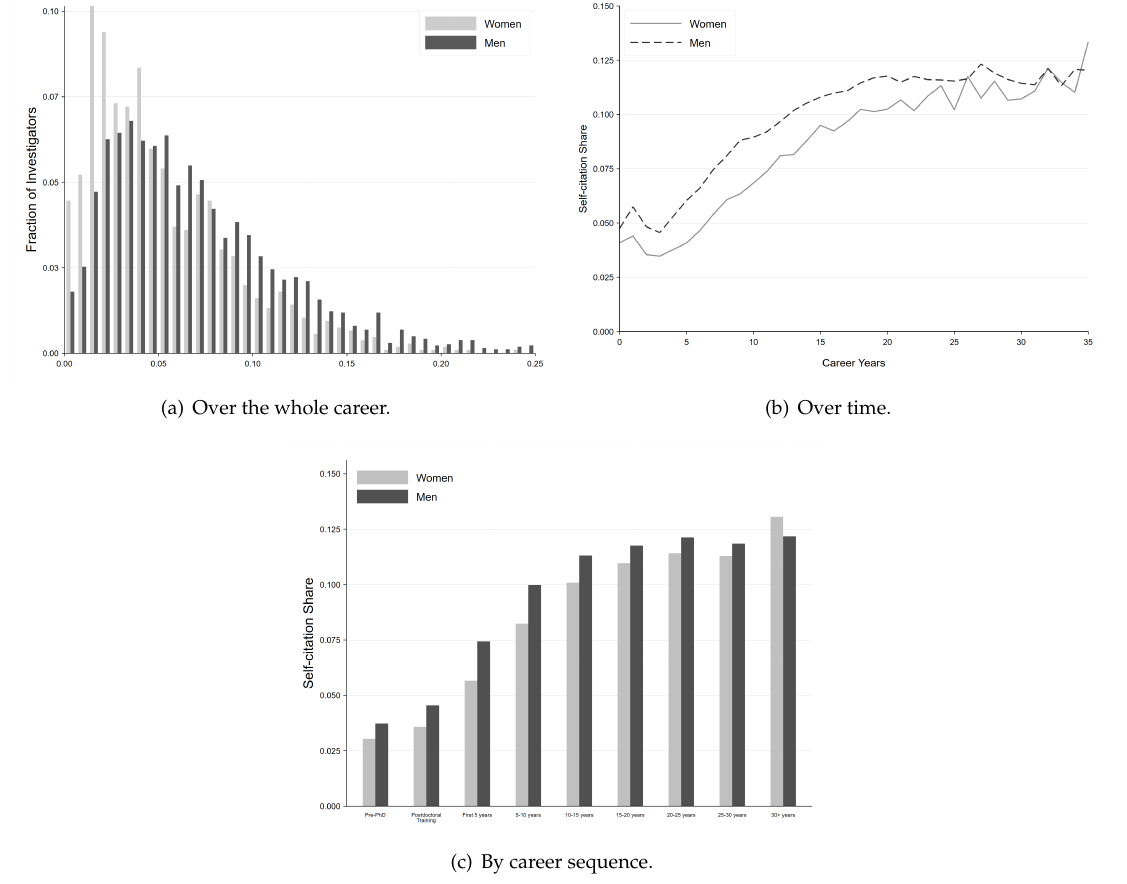
Figure 2: Self-reference rates—scientist